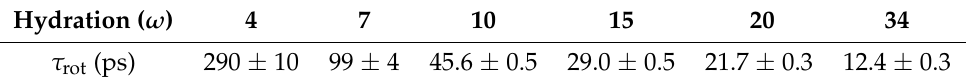
Table 1. Rotational relaxation time as calculated in Equation (3) for the dipolar correlation